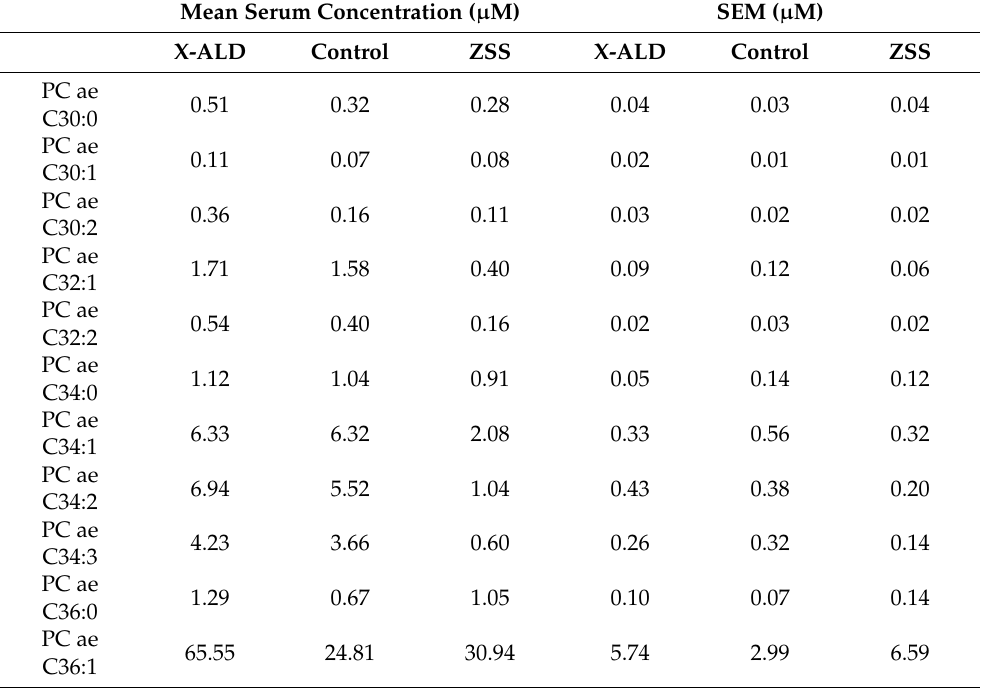
Table A1. Serum from patients analyzed using the Biocrates AbsoluteIDQ p180 kit. ZSS pa- tients show aberrant serum concentration of ether-linked phospholipids. Concentrations of ether- phosphatidylcholine species (PC ae) in µ M, n = 36 (X-ALD/ ABCD1 ), 28 (Controls), 17 (ZSS/ PEX1